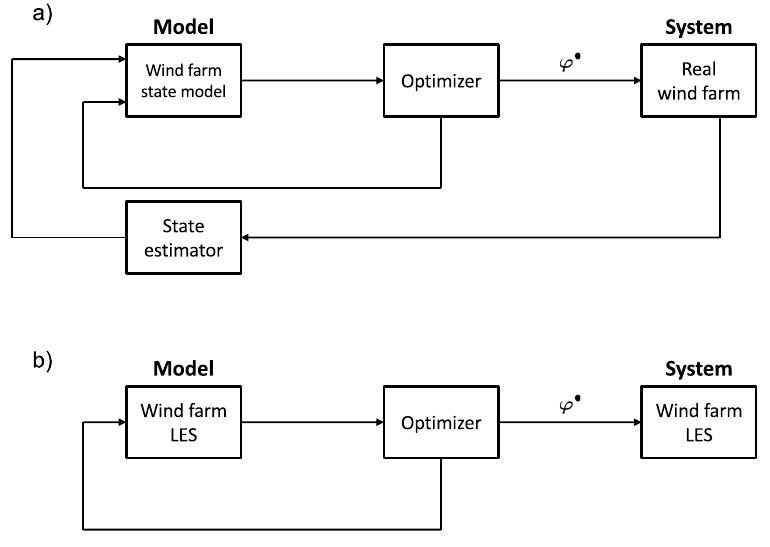
Figure 1. Model-predictive control (MPC) applied to wind farms. ( a ) Conventional feedback MPC of a wind farm. ( b ) Benchmark optimal control framework of a wind farm large-eddy simulations (LES) considered in the current study. Figure originally published in Munters and Meyers [14] under a CC-BY 4.0 license.